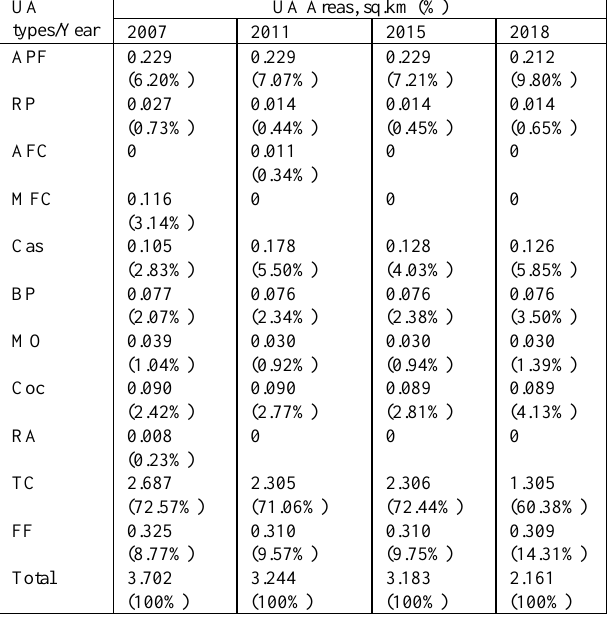
Table 4. Summary statistics of UA sites identified in MNC of Thailand classified into the eleven